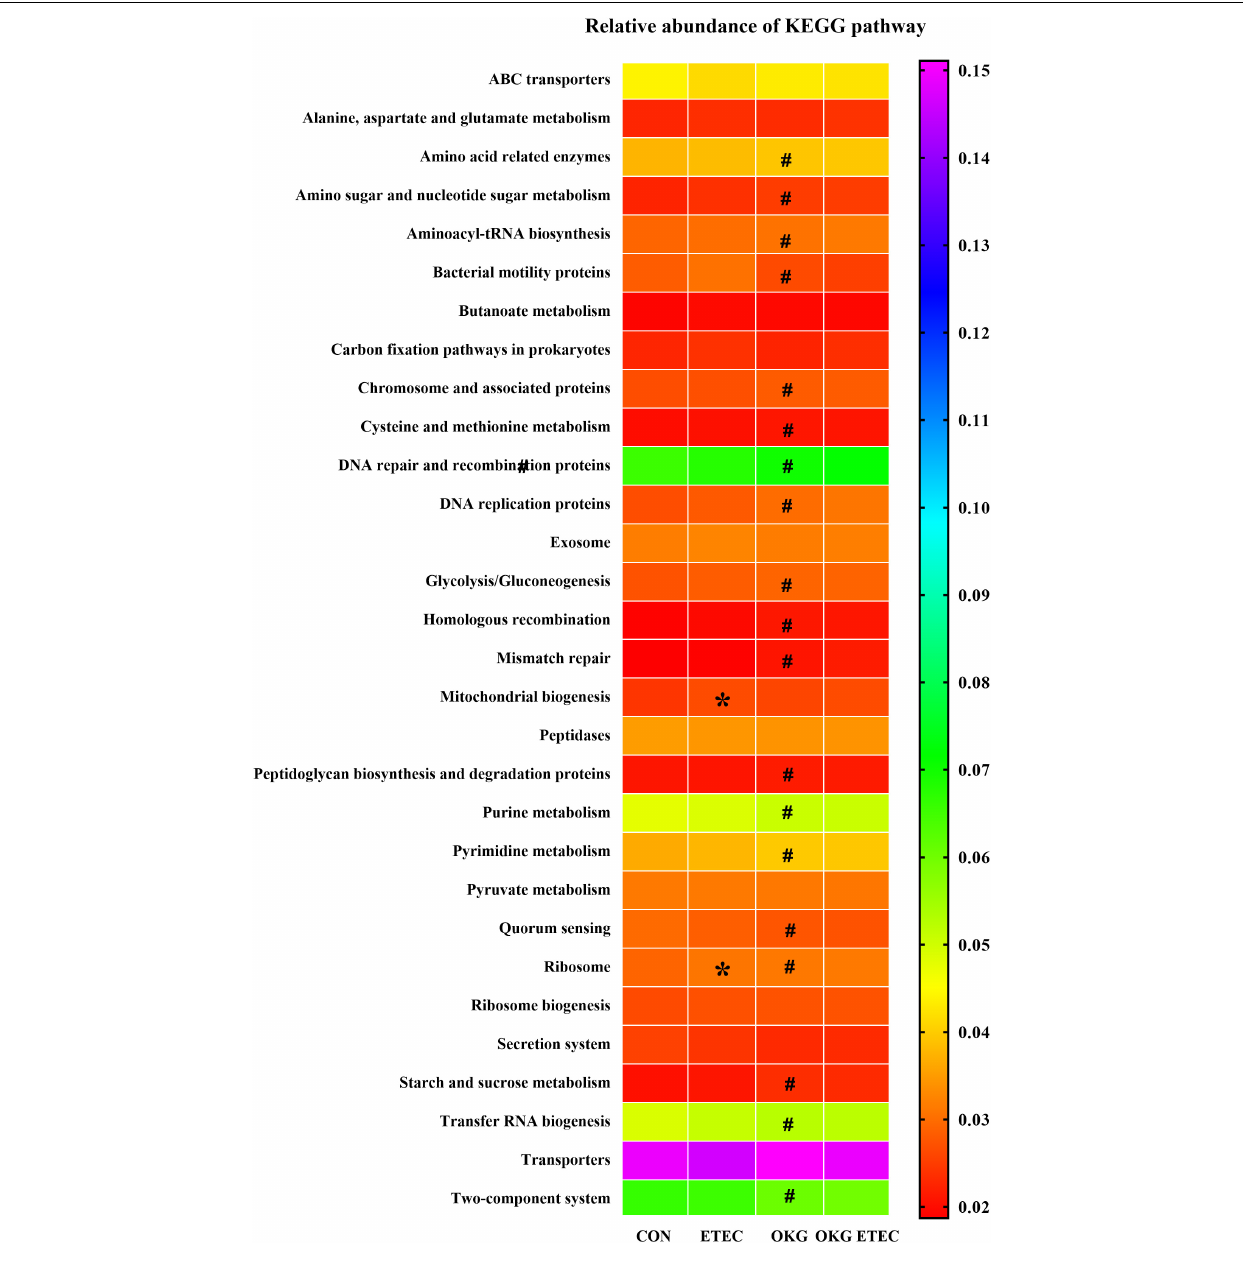
FIGURE 4 | Predictive functional profiling of microbial communities by PICRUSt. KEGG pathway annotations in level 3. Values are presented as mean ± SEM. *Indicates a statistically significant difference for the challenge (ETEC or LB Broth) ( p < 0.05). # Indicates a statistically significant difference for dietary treatment (basal or OKG diet) ( p <